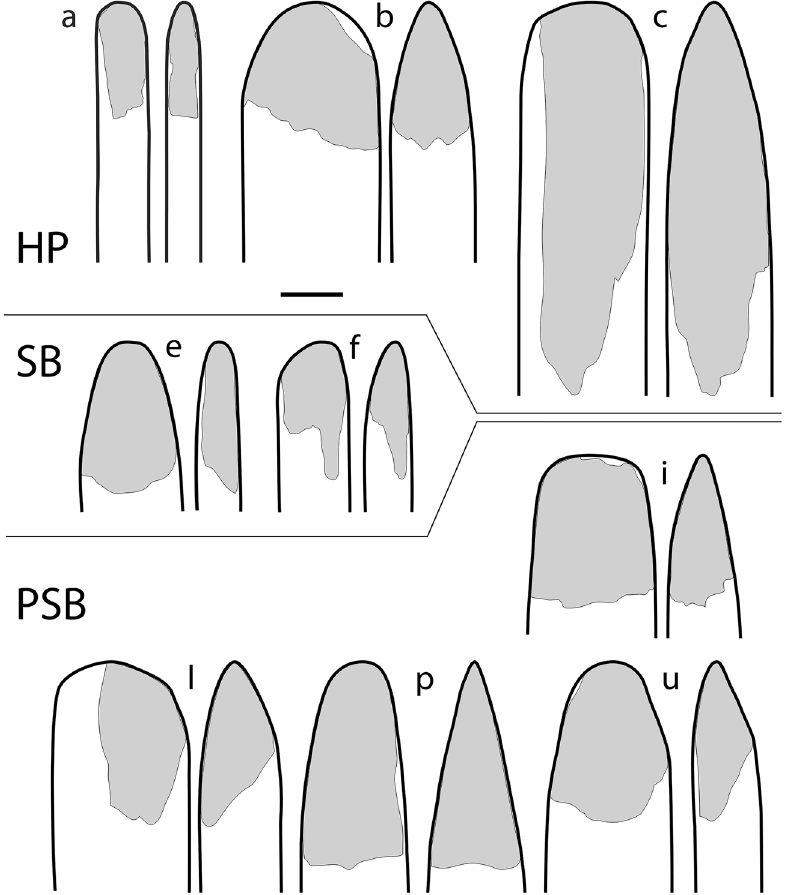
Figure 4. Reconstruction of planar and lateral profiles of the best-preserved double-beveled bone tools from Sibudu . The profile reconstruction (thick black outline) is based on complete or near complete specimens found in Howiesons Poort ( a – c ), Still Bay ( e – f ) and pre-Still Bay ( i , l , p , u ) layers. Grey shaded areas indicate the preserved portion of the tools. Letters match those in Fig. 2 where photographs of the archaeological objects are presented. Scale: = 1